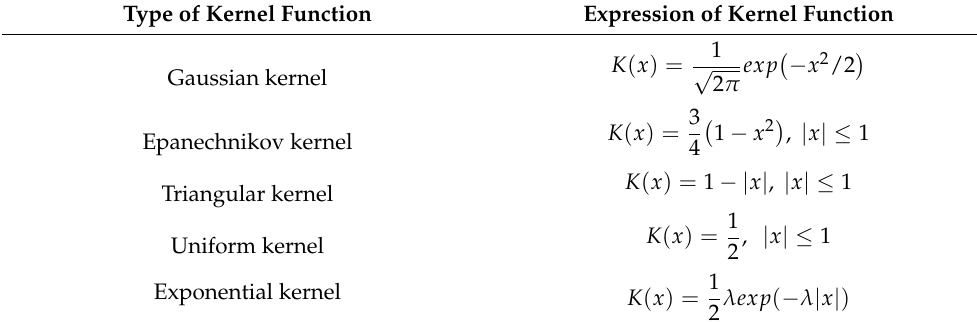
Table 1. Common kernel